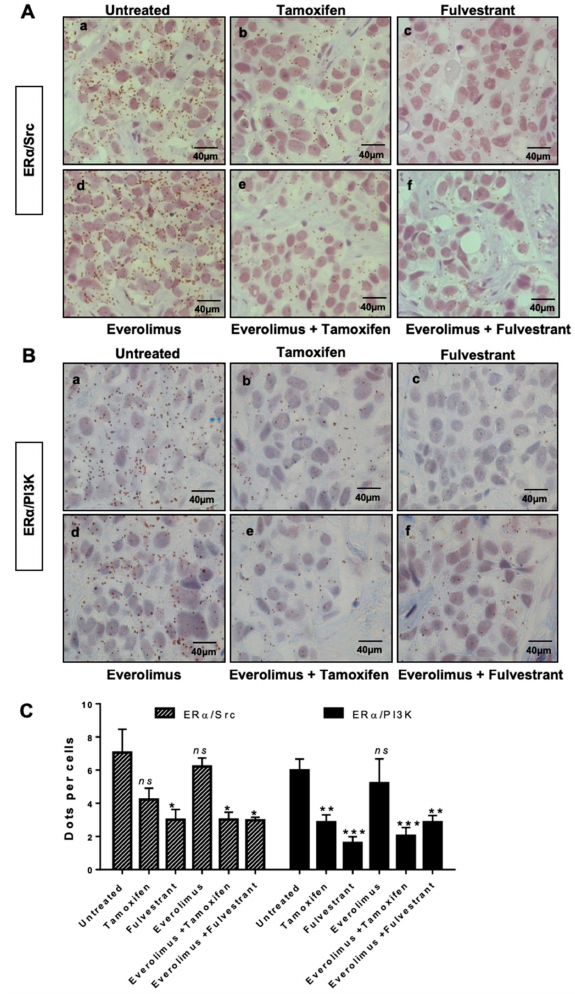
Figure 2. ER α / Src and ER α / PI3K interactions in HBCx22 TamR PDX model treated with everolimus combined or not with endocrine therapies. HBCx22 TamR mice were treated with tamoxifen, fulvestrant, everolimus, everolimus, and tamoxifen or everolimus, and fulvestrant prior to being sacrificed. The tumours were then embedded in para ffi n and included in tissue micro arrays (TMA). Bright field proximity ligation assays were subsequently conducted on TMA sections to analyse the interactions between ( A ) ER α and Src or between ( B ) ER α and PI3K. n = 3 xenografts / group ( C ). Quantification of results obtained was performed by counting the number of signals per cell in three independent zones of the section. ( n ≥ 500 cells counted / tumour). Significance ( p -value) between treatments was determined using the Student t -test. *** p <